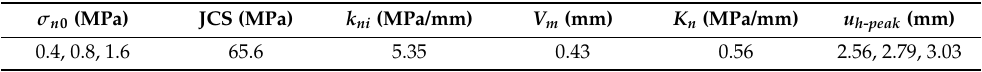
Table 1. Related parameters for calculating fracture aperture.